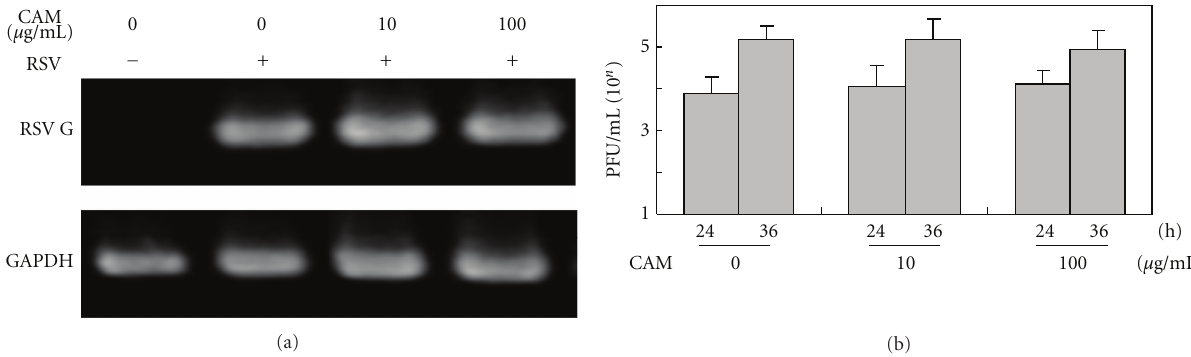
Figure 1: E ff ects of CAM on RSV G mRNA expression (a) and production of infectious virus particles (b) in A549 cells infected with RSV. One hour before RSV infection, CAM was added to A549 cell culture at the indicated concentration. A549 cells were infected with the RSV at MOI of 1. (a) RT-PCR. After 24h of infection, total RNAs were extracted from the cells. The mRNA levels of RSV G were determined by RT-PCR. The mRNA levels of human glyceraldehyde-3-phosphate dehydrogenase (GAPDH) were carried out as a control. (b) Plaque- forming assay. After 24 h and 36h infection, the culture supernatants were corrected. Virus titers in the supernatants were determined by plaque-forming assay using Hep-2 cells as the indicator cell. Each experiment was performed in quadruplicate. The mean value and standard deviation are